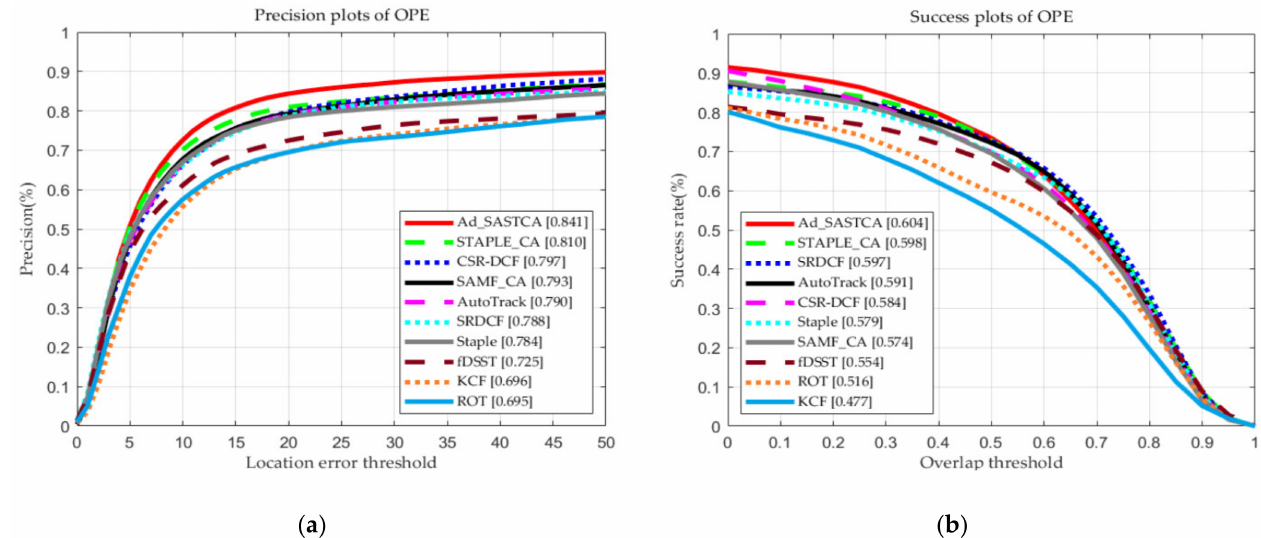
Figure 4. Overall results of precision plot ( a ) and success plot ( b ) comparing Ad_SASTCA with nine state-of the art trackers on OTB-2015 dataset. The trackers in figures ( a ) and ( b ) are sorted according to precision and AUCs,